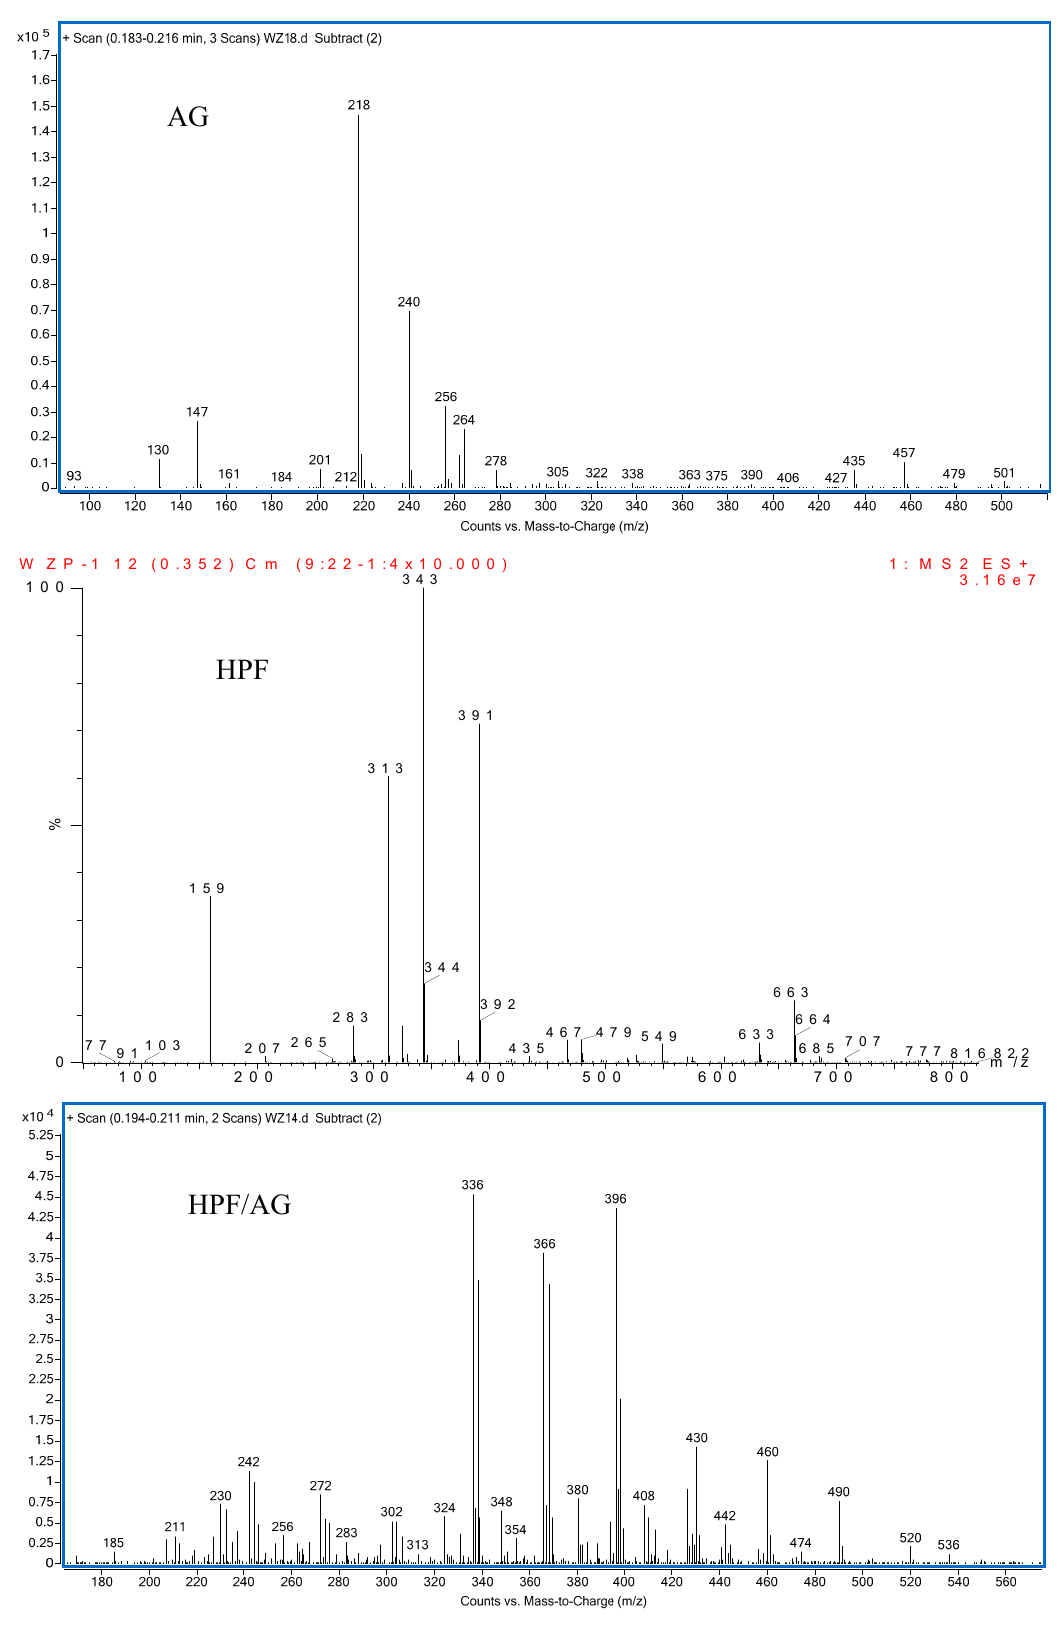
Figure 3. ESI-MS spectra of N -(2)- L -alanyl- L -glutamine (AG), HPF and HPF/AG.